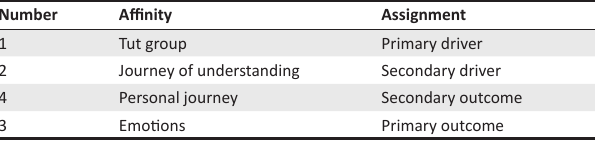
TABLE 4: Focus group: Tentative systems influence diagram assignment.